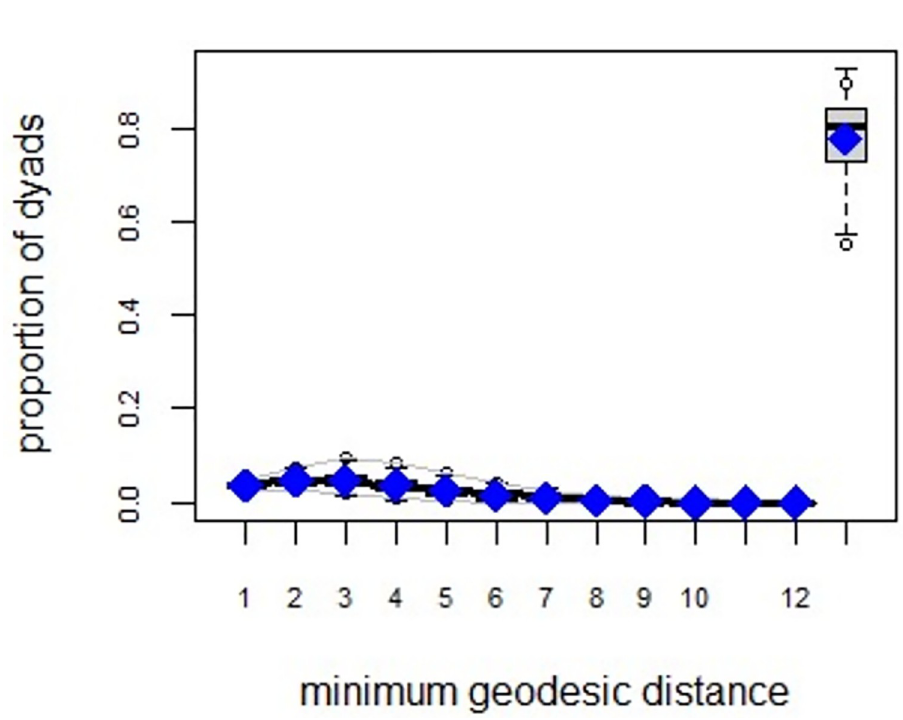
Fig 16. Multiplexity in the beta community—goodness of fit [24] minimum geodesic distance.